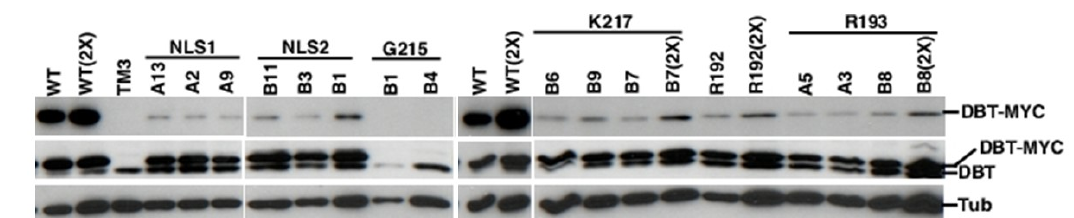
Figure 3. Analysis of transgenic and endogenous DBT levels in the heads of flies collected at ZT7.